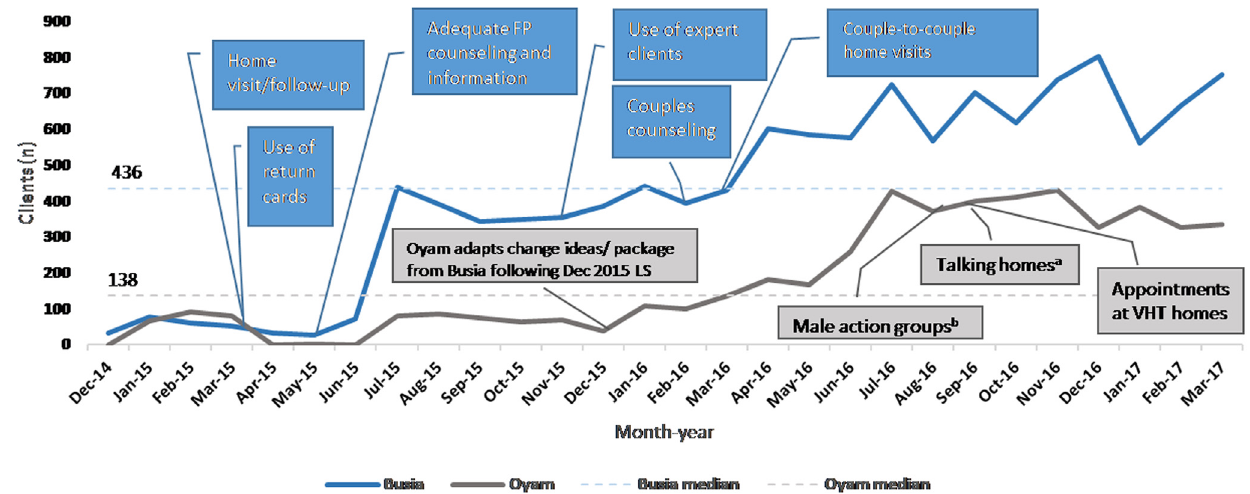
Figure 3. Number of family planning (FP) clients returning for follow-up, December 2014 - March 2017. Annotated run chart with examples of change ideas implemented over time. a Talking homes: displaying FP posters and providing confidential space in Village Health Team (VHT) home for services. b Male action groups: groups of men formed to support community mobilization and dissemination efforts typically found in Northern Uganda. These men were selected by community members based on trust and